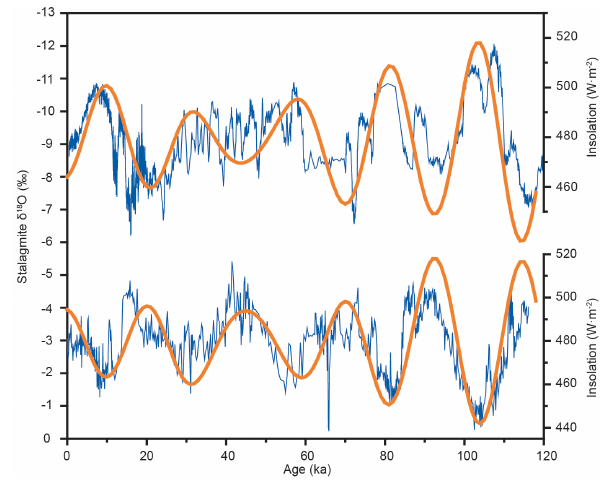
Figure 15. Late Quaternary variations of the Asian and South American monsoons as indicated by stalagmite δ 18 O records (blue) from southern China (Hulu and Dongge caves) (Y. Wang et al., 2008) and Brazil (Caverna Botuverá) (Cruz et al., 2005). Thick orange lines represent summer daily insolation changes at 30 ◦ N (21 June, upper curve) and 30 ◦ S (21 December, lower curve) (Berger and Loutre,